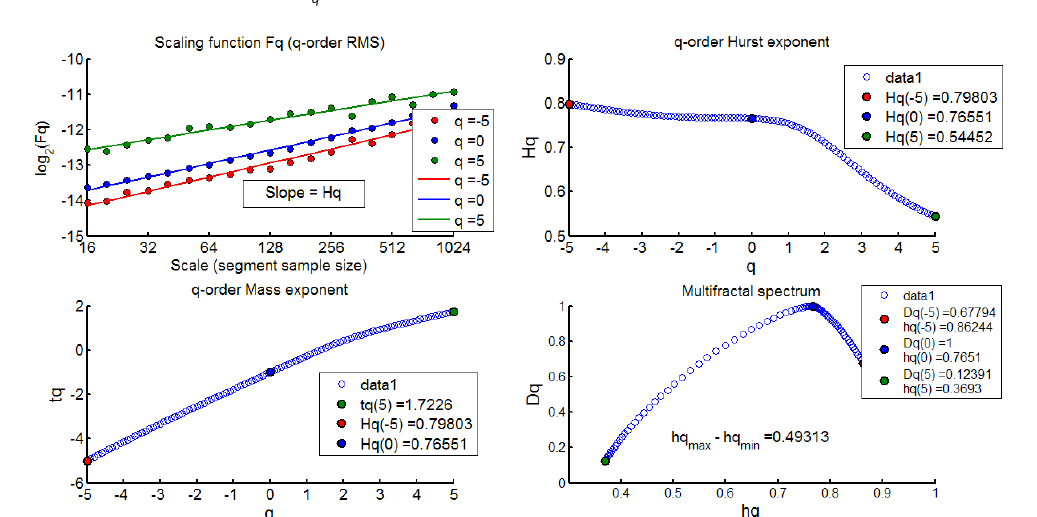
(5) of Nifty Pharma index on June 15, 2020, i.e., ( t = Figure 7. The H q